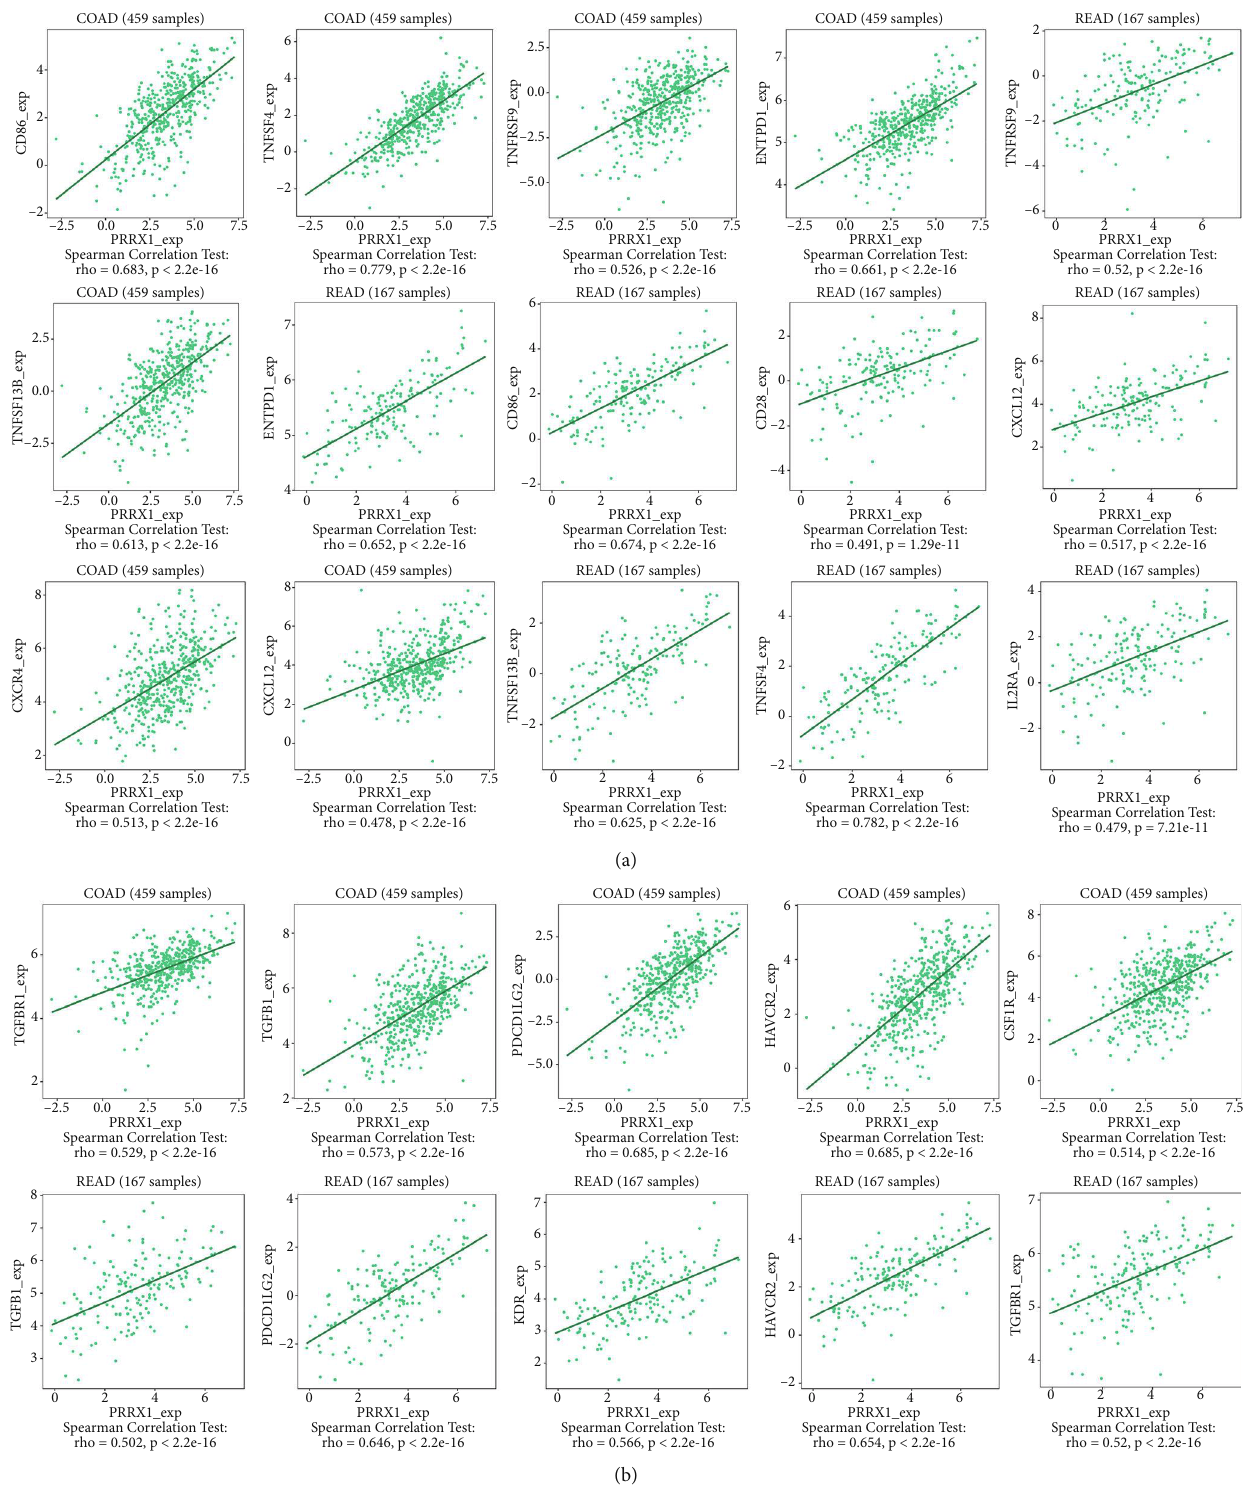
Figure 9: The expression of PRRX1 is associated with immunomodulators in CRC. (a) Correlation between PRRX1 expression and immunoinhibitors in CRC available at TISIDB database. (b) Correlation between PRRX1 expression and immunostimulators in CRC available at TISIDB